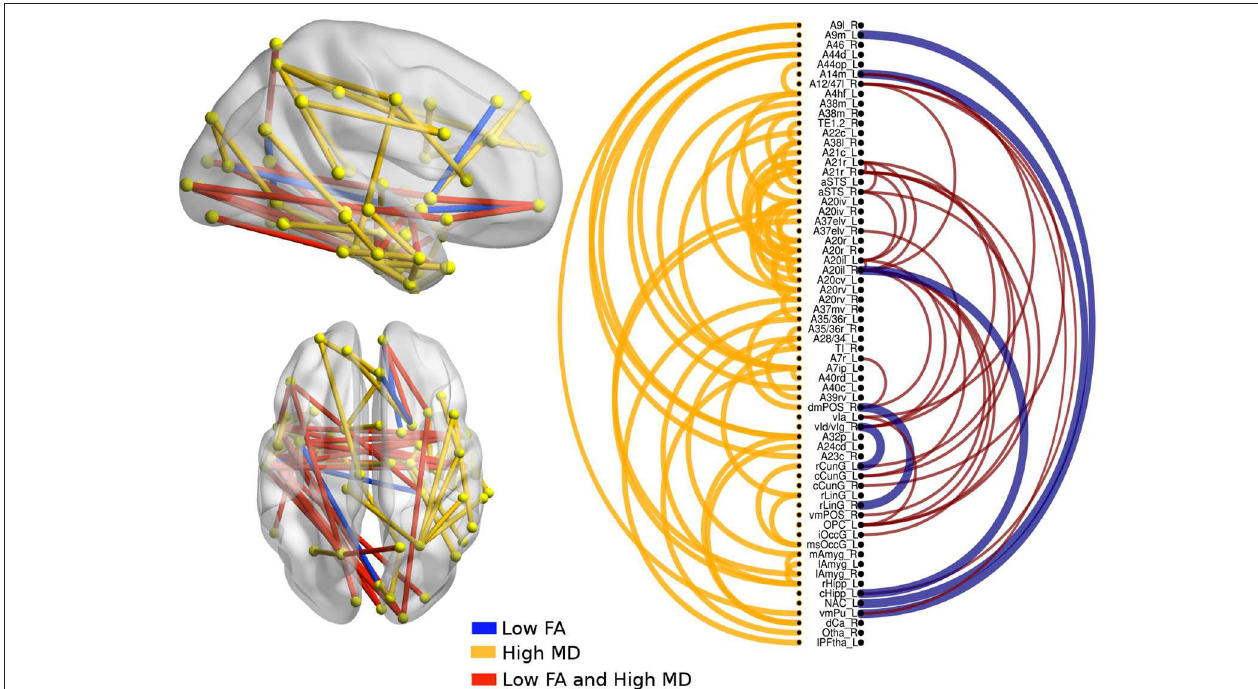
FIGURE 3 | Atrophic networks in the svPPA variant with respect to bvFTD. The labels from Brainnetome represent the nodes and the edges show the changes in FA and MD. Only the edges with changes are shown. The whole list of the nodes with the names is located in Supplementary Data . The left of the figure shows alterations overlaid on a 3D template in the Montreal Neurological Institute’s standard space in neurological convention. The right side shows the same results displayed in 2D with the names of nodes in the Brainnetome Atlas and displayed at p <